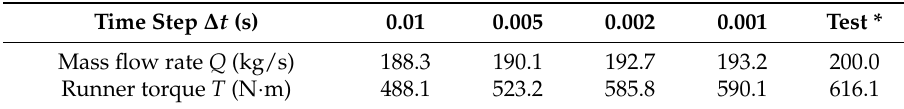
Table 3. Dependency analysis for the time